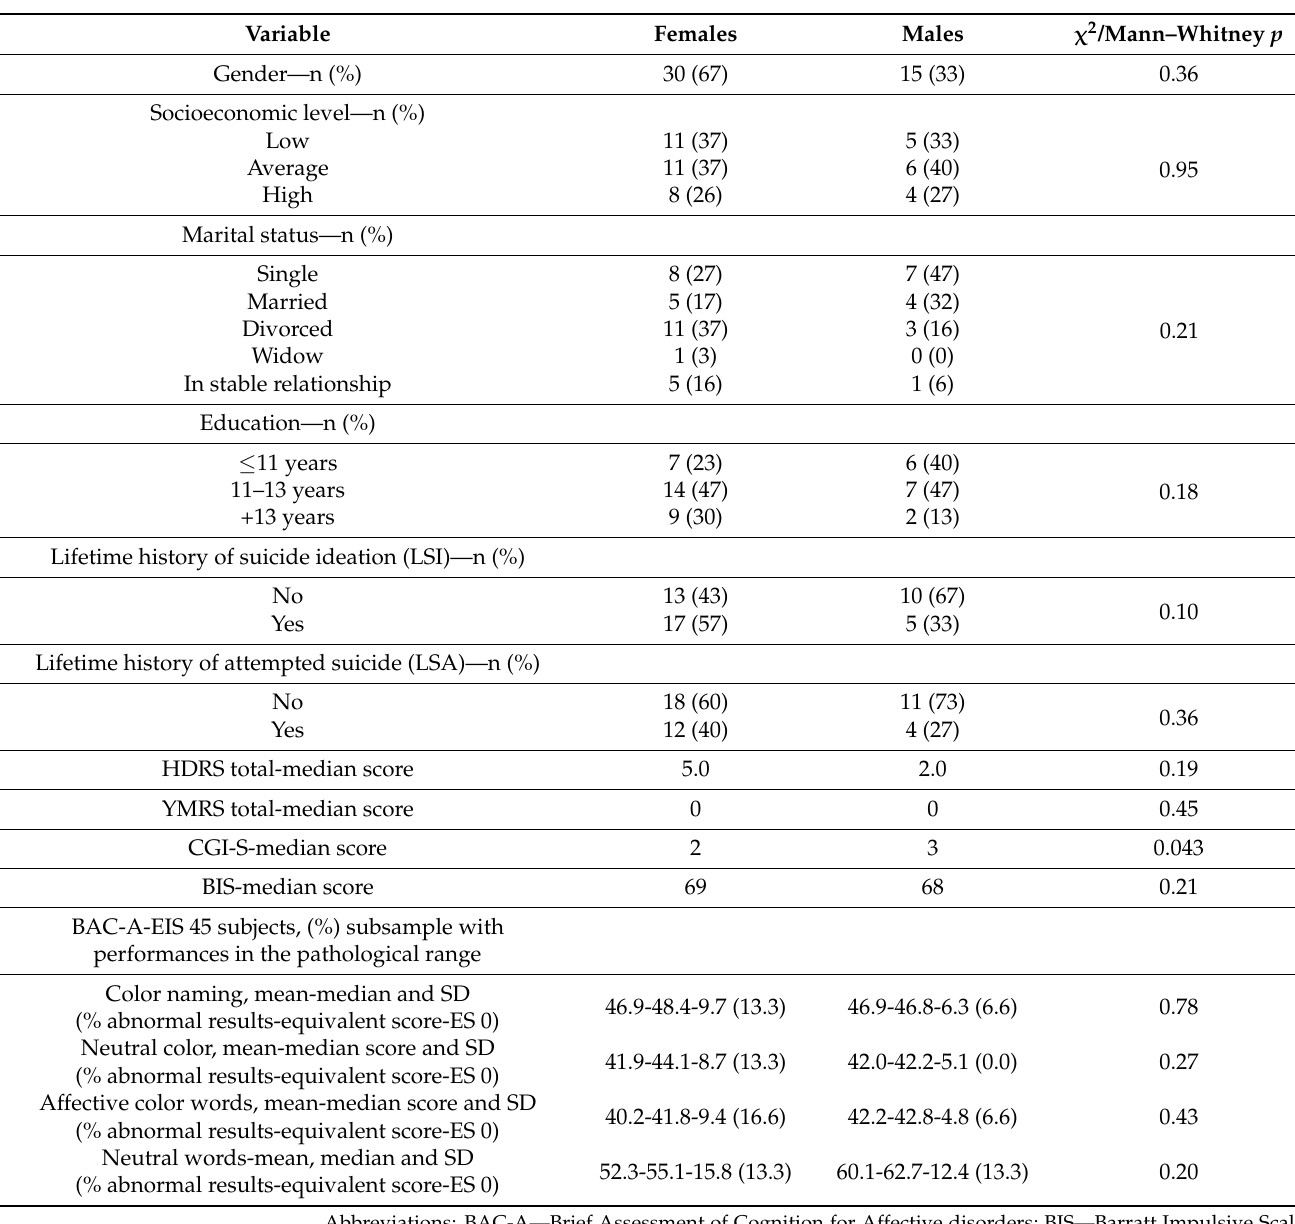
Table 2. Sociodemographic data and psychometric test results for the sample of 45 patients with BD. Variable Females Males χ 2 /Mann–Whitney